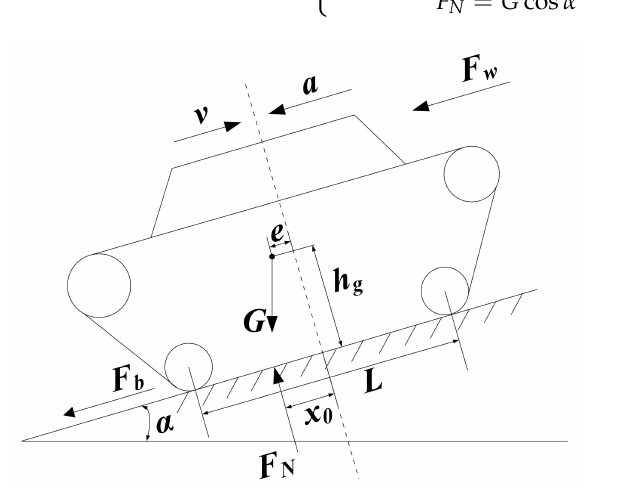
Figure 11. Force analysis of longitudinal slope tracked